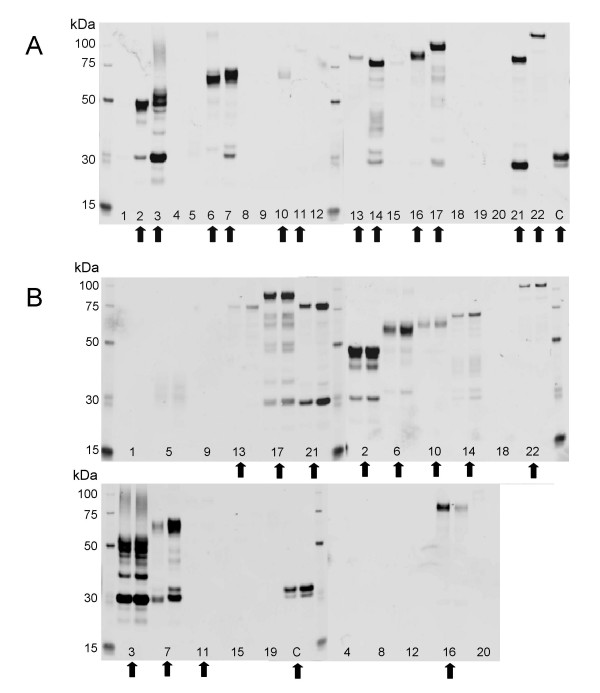
Protein expression in 24 well blocks and 50 ml flask culture. Supernatants from 50 ml shake flask (A) and 2 ml 24 well block (B) transient transfections were analysed by Cy5 western blot. The 13 vectors which are positive for protein production are indicated by arrows. In B, the two different seeding density samples from the 24 well blocks were run adjacent to each other with the lower seeding density sample loaded first. The control protein C was rCD4 (domains 3 + 4)-His10 expressed from vector C, Figure 1.